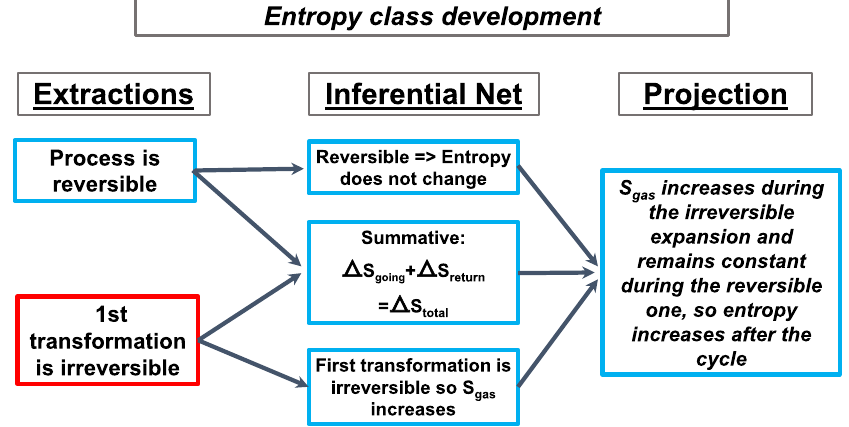
FIG. 3. Development of the entropy class during segment 1. F ’ s contributions in blue frames, D ’ s contributions in red frames, where S stands for the entropy of the gas and Δ S the entropy variation. gas